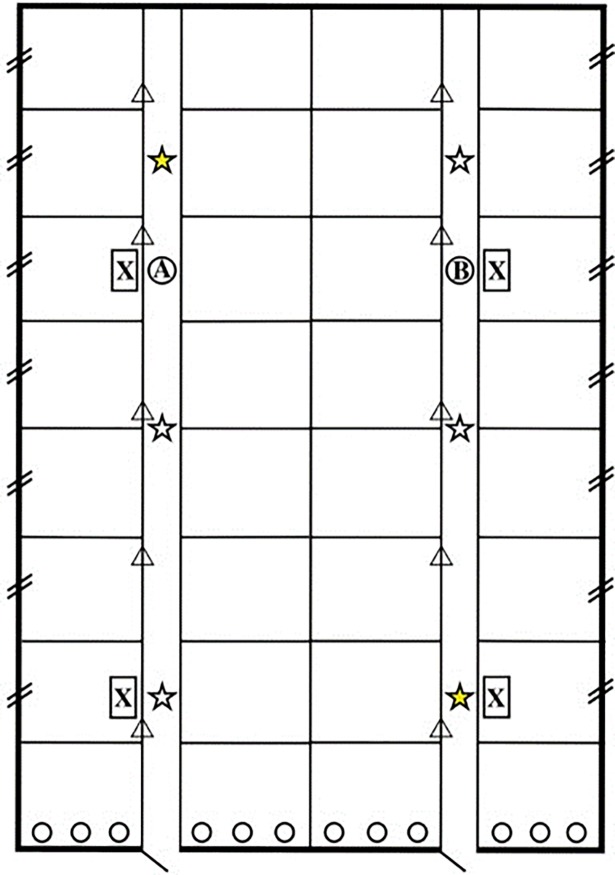
Structure of the four barns and sampling points.Each barn consisted of 32 pens and was accessible via two doors. Exhaust air outlets in each barn are given as circles. Slashes on both sides of the picture symbolize the fresh air inlets of barn 3 and 4. Triangles indicate the fresh air distributors of barn 1. Dust was measured at two sampling locations that were randomly selected on the day of sampling but were identical with the sampling points for air sampling. The latter sampling points (n = 6) are indicated by stars. Stars in yellow indicate sampling points for ammonia (NH3). A (barn 1 and 3) and B (barn 2 and 4) represent the positions of the sensors for CO2 and relative humidity. Recirculating air filter modules in barn 4 are represented by a framed X.